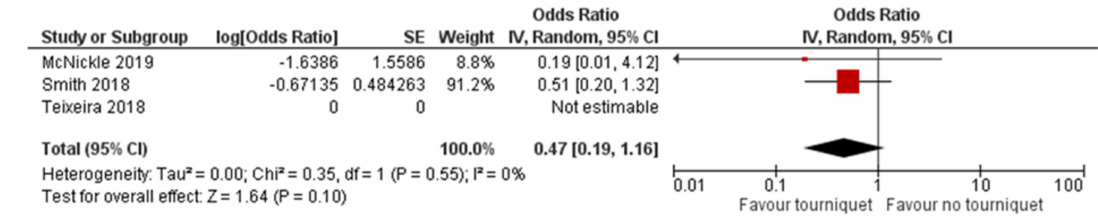
Figure 2. Adjusted odds ratio for overall mortality of pre-hospital-TQ vs. no pre-hospital-TQ.